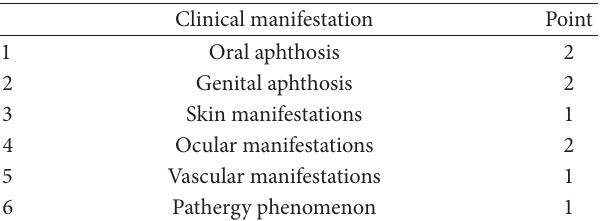
Table 1: International Criteria for Behc¸et’s Disease [1].